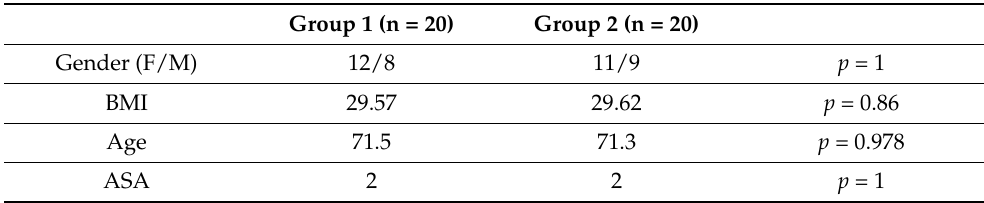
Table 1. Results for basic demographic variables. The differences between the groups are statistically nonsignificant.